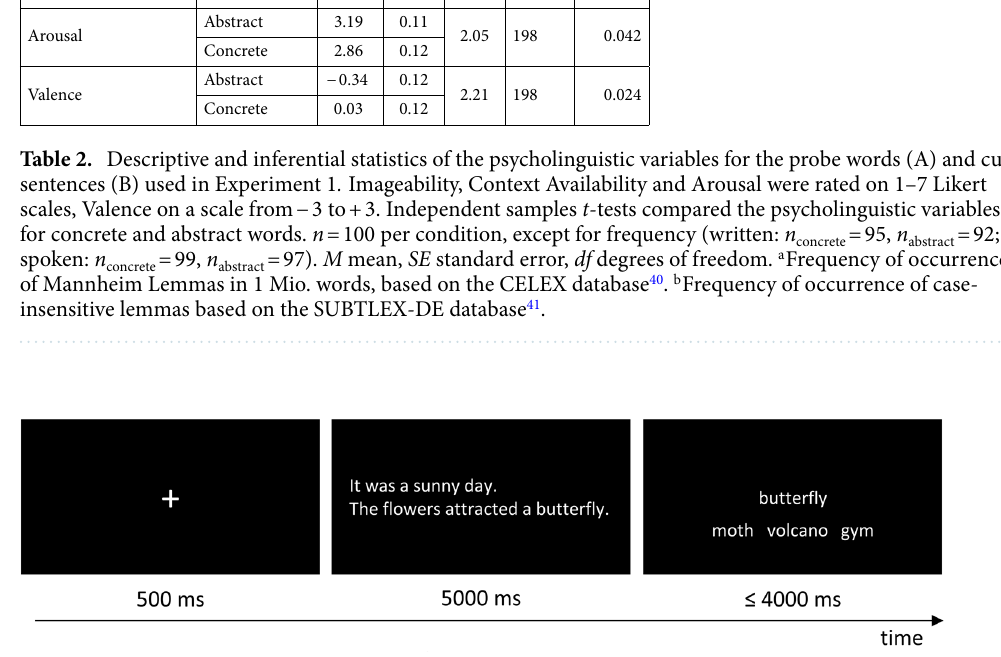
Figure 1. Timing and exemplary stimuli of one trial of the synonym judgment task with a contextual cue and a concrete